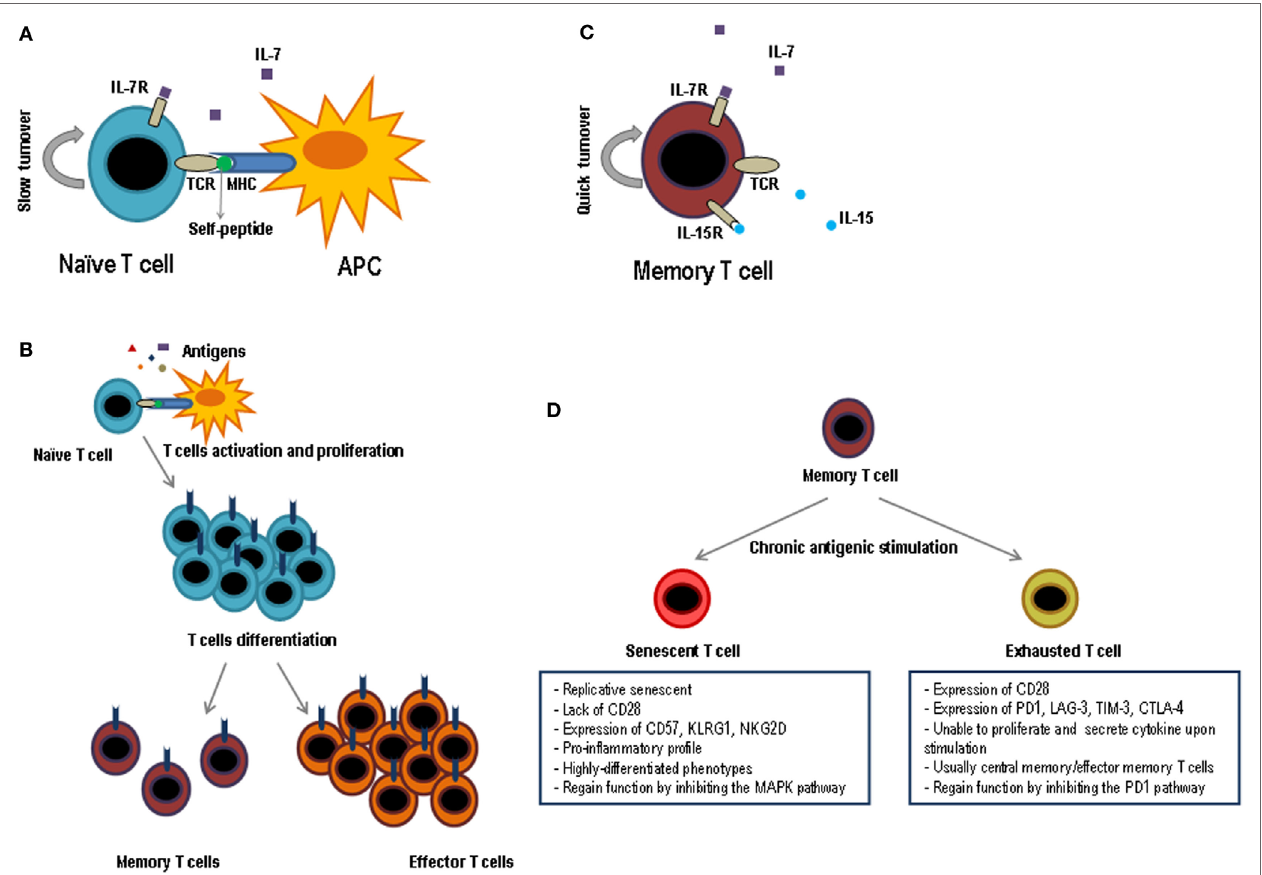
FiGURe 2 | Functional phases of T lymphocytes. Schematic representation of the key factors for survival and maintenance of naïve cells (A) and memory (C) ; while naïve cells are dependent on IL-7 and the contact with self-peptides by MHC, memory cells are dependent on IL-7 and IL-15 and do not need the contact with autoantigens. (B) After contact with its specific antigen, naïve T lymphocytes proliferate exponentially and give rise to two differentiated populations, effector T lymphocytes and memory T lymphocytes. Effector cells will be eliminated as soon as the pathogen is destroyed, while memory cells will last a long time and they will be responsible for protecting the individual against new infections caused by the same pathogen. (D) When the memory cells are subjected to multiple cycles of activation by means of chronic antigens they can generate two types of T lymphocytes, exhausted T lymphocytes and senescent T lymphocytes. The principal characteristics of both cell types are shown in the